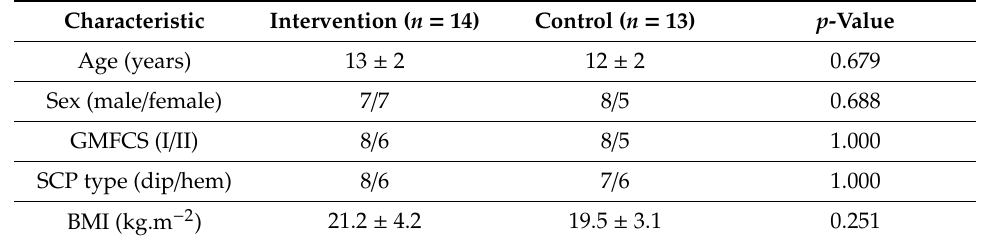
Figure 1. Flowchart of study participants. Table 2. Patients’ baseline characteristics by group.